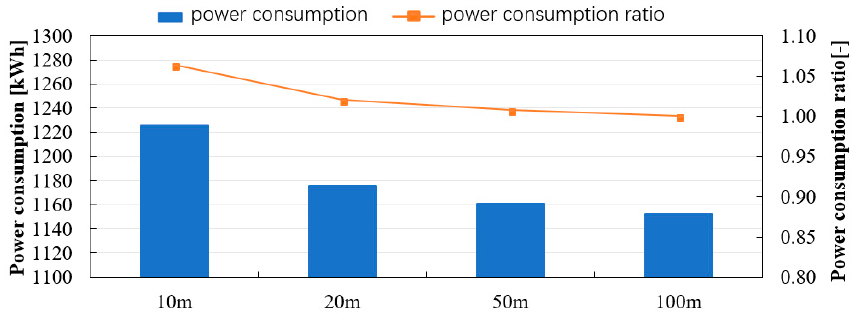
Figure 15. Total energy consumption for different length of GHE. (Effective thermal conductivity 1.0 W/m.K).